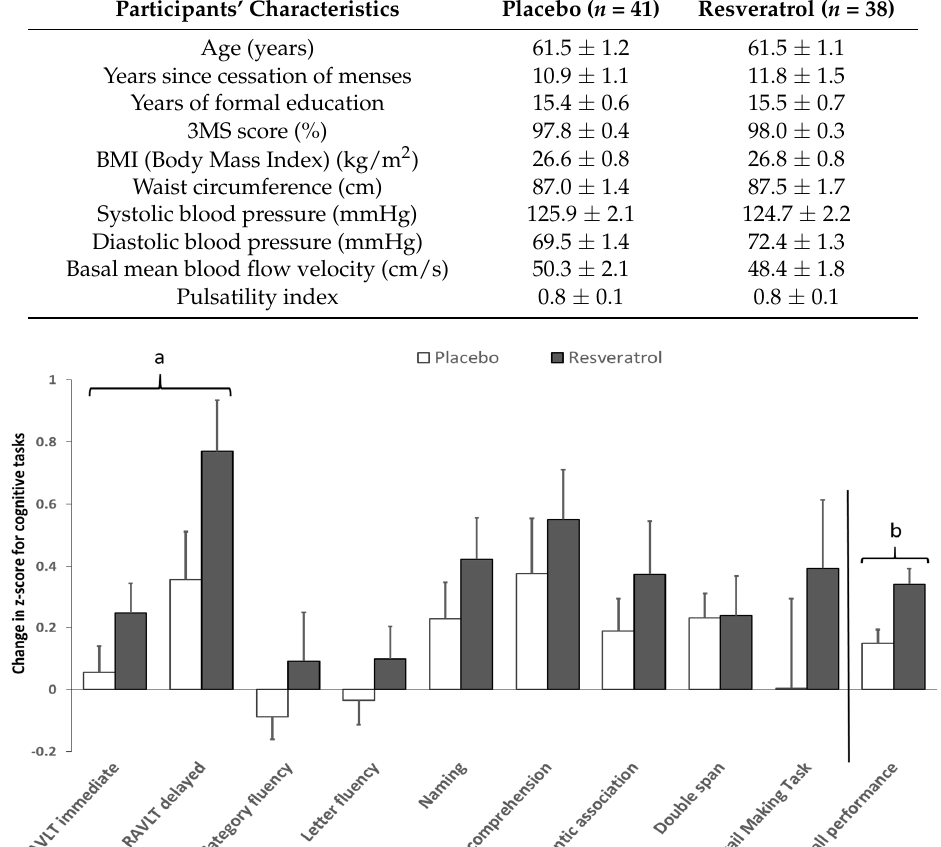
Table 1. Participant baseline characteristics ( n = 79). Data are presented as mean ± SEM (standard error of mean).